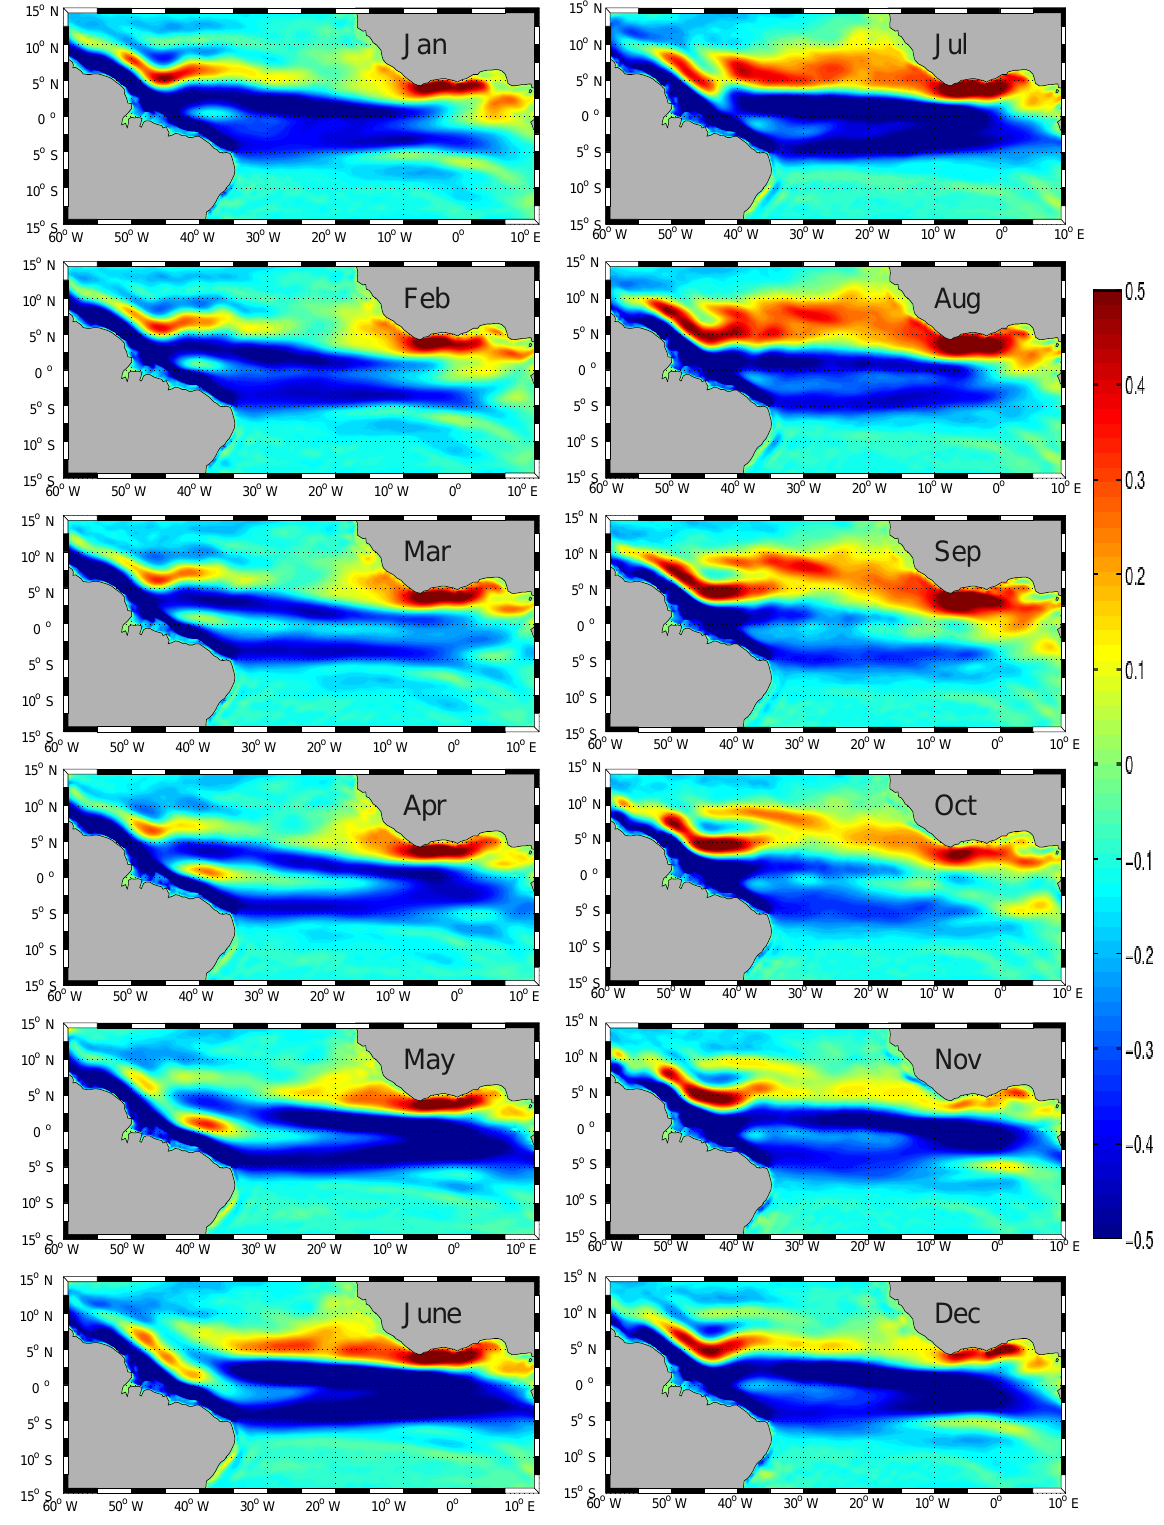
Figure 2. Model monthly climatology of zonal velocity at the ocean surface (ms − 1 ). This figure should be compared with Fig. 6 in Rosell- Fieschi et al.